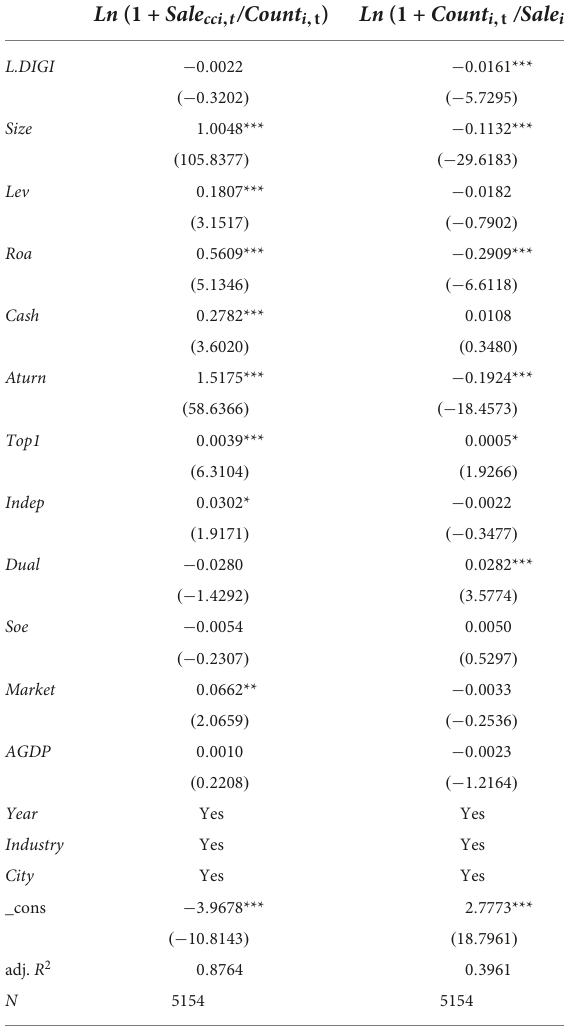
TABLE 12 Regression results for the decomposition of customer structural diversity.